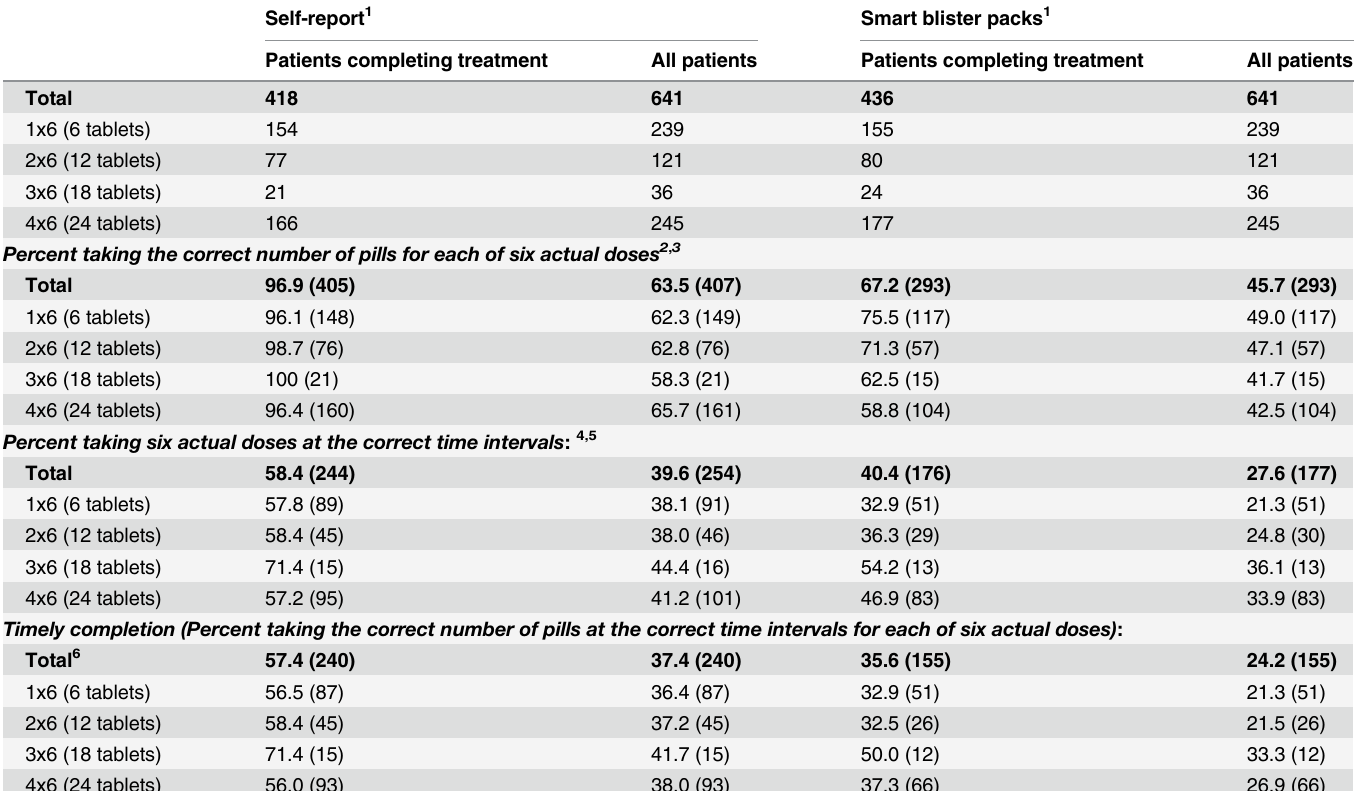
Table 3. Timely completion by self-report and smart blister packs 1 (percent